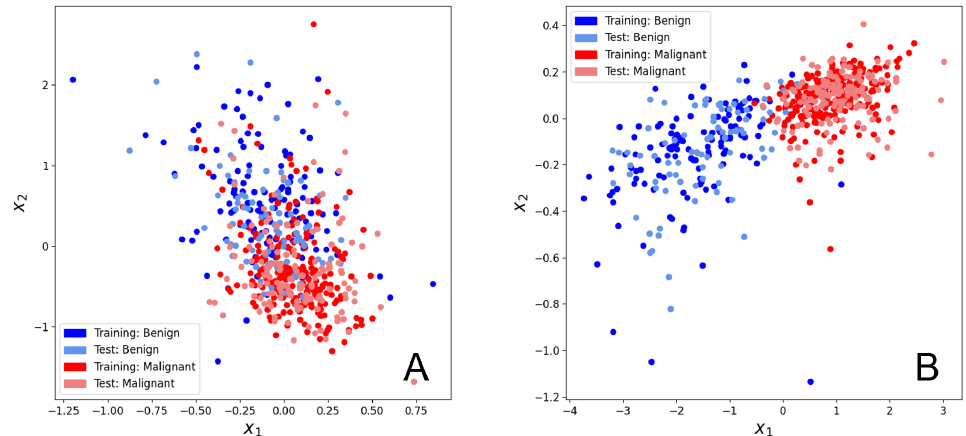
Figure 3. Scatter plots of the ( x 1 , x 2 ) values of the breast cancer dataset with 30 starting features (corresponding to 60 trainable linear parameters). Datapoints from both the training set and the test set are depicted. A random seed of ’1’ was used for the train-test split of this data. The PennyLane software package was used to optimize the parameters [40]. ( A ) Scatter plot of the ( x 1 , x 2 ) values after 0 training steps. ( B ) Scatter plot of the ( x 1 , x 2 ) values after 1500 training